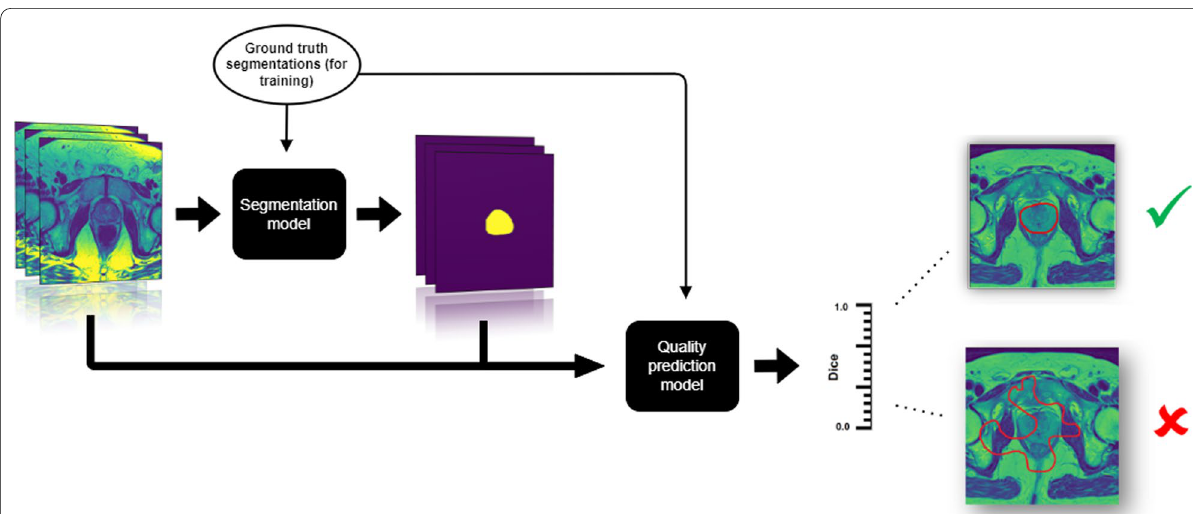
Fig. 1 Overview of the problem of predicting the quality of organ segmentations. First, a segmentation model (not covered in this article) takes images as input and produces segmentation maps. Then, our quality prediction model takes both the images and the segmentation maps as input and produces an estimate of the quality of the segmentation—in this case the Dice similarity coefficient. Good contours have a high Dice value and poor contours have a low Dice value. Note that we need ground truth segmentations in order to calculate the true Dice value and train the quality prediction model with supervised learning. In this study, we used 60 ground truth segmentations and 80 automatically generated masks along with heavy data augmentation to train the quality prediction model